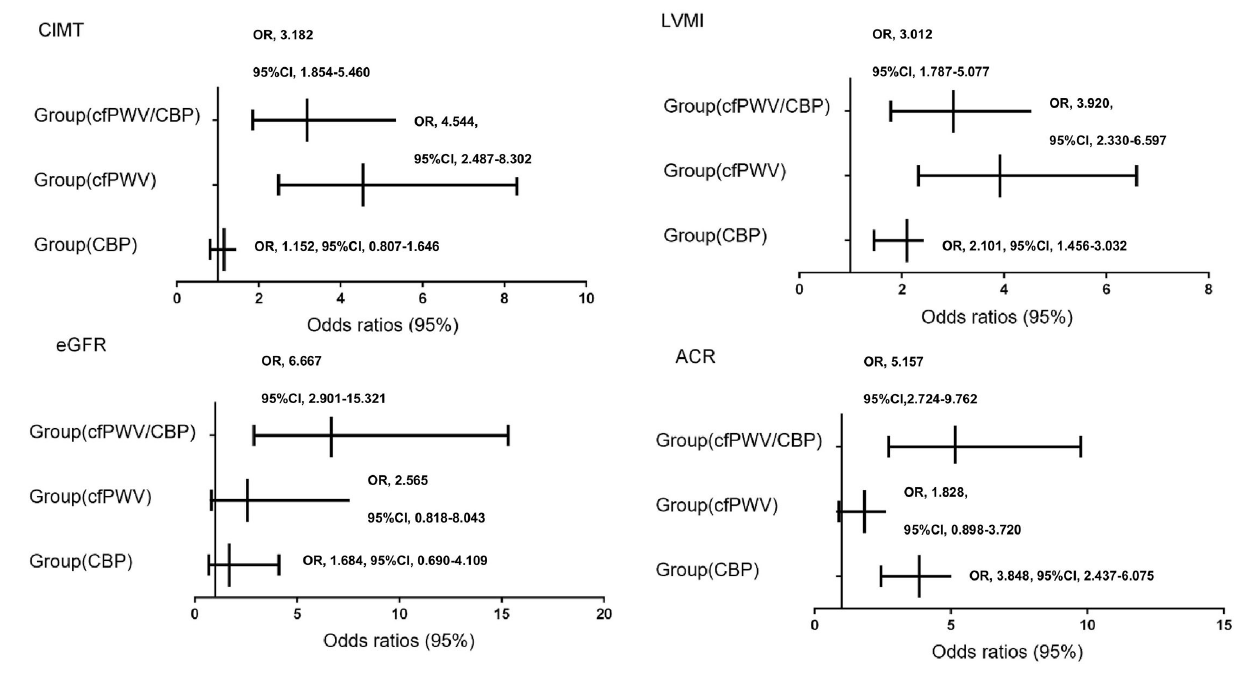
FIGURE 2 | Multiple stepwise logistic regression of target organ damage among groups by cf-PWV and CBP without adjusted factors. Groups by cfPWV and CBP status: Group ( cfPWV/CBP ): high cfPWV and high CBP; Group ( cfPWV ): high cfPWV and normal CBP; Group ( CBP ): normal cfPWV and high CBP; Group ( control ): normal cfPWV and normal